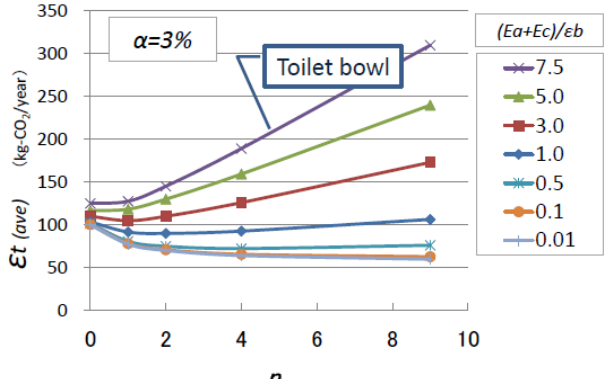
Figure 10. Environmental impacts of toilet bowls.